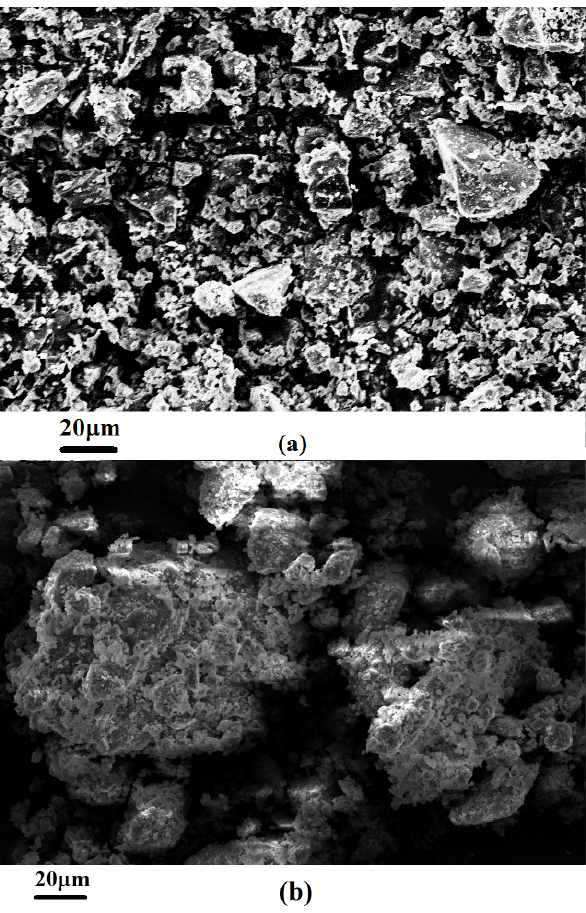
Figure 3: SEM of (a) cement and (b) limestone filler.